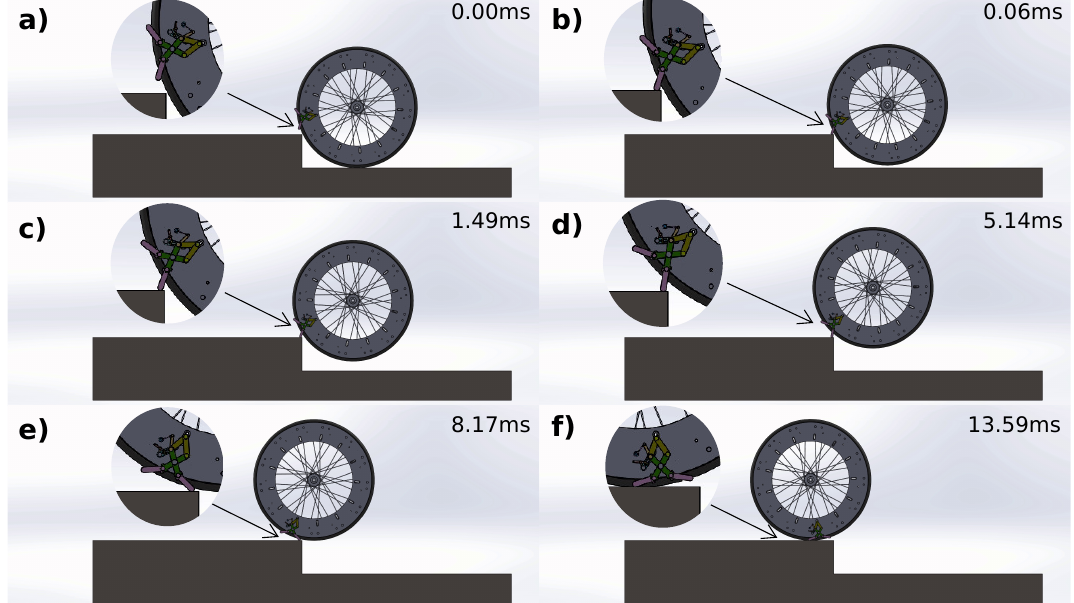
Figure 20. Motion simulation of the mechanism while ascending a step (time stamp in milliseconds are roughly estimated from videos) ( a ) the tip of link 2 is about to touch the edge of the step; ( b ) the tip of link 2 touches the edge of the step; ( c ) link 2 becomes parallel to link 1; ( d ) wheel climbs half way; ( e ) as the climbing is about to complete link 2 returns to initial position; ( f ) climbing is complete.